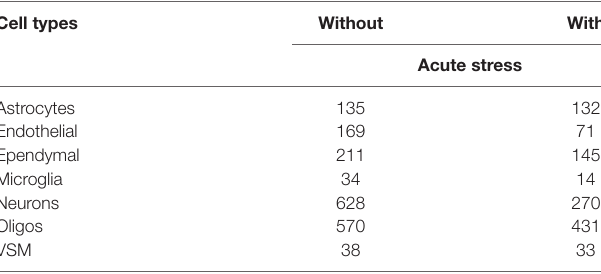
TABLE 1 | The number of cells that belong to either without or with acute formalin stress or cell types. TABLE 2 | Confusion matrix of coincidence between selected 55 singular value